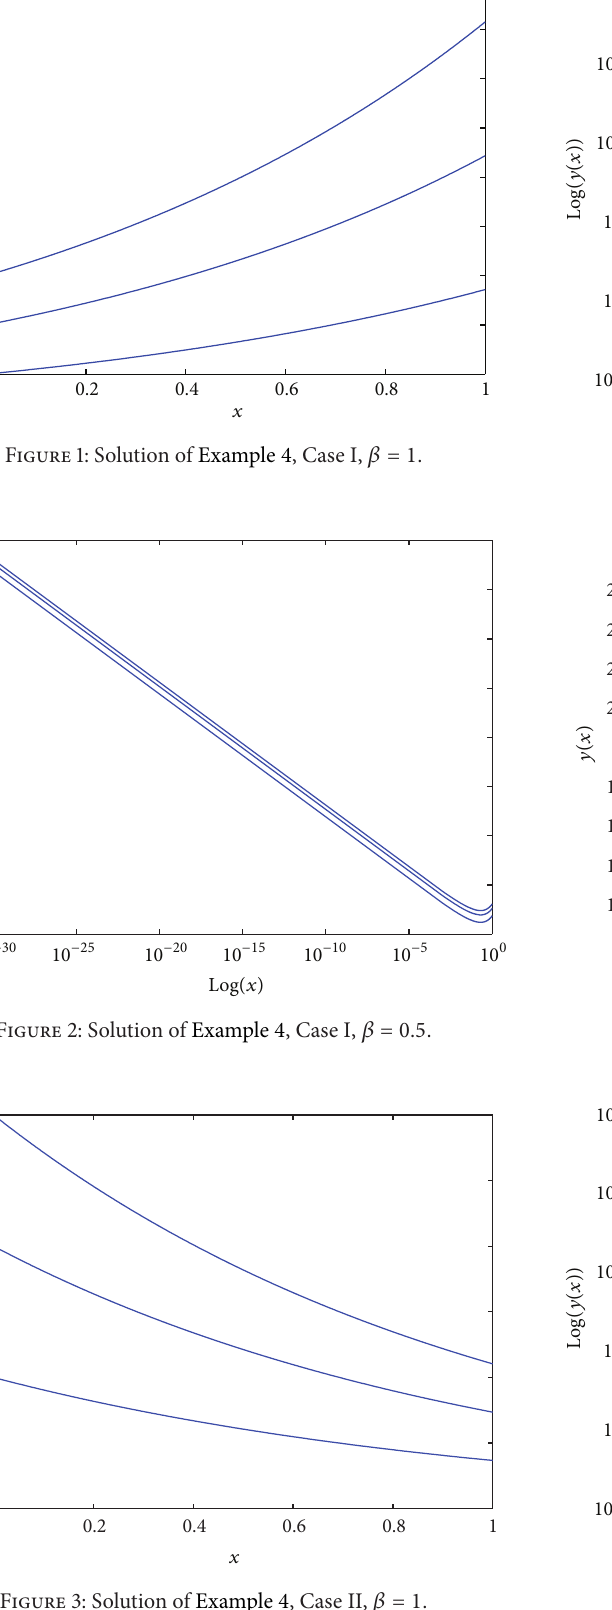
Figure 3: Solution of Example 4, Case II, 𝛽 = 1 .